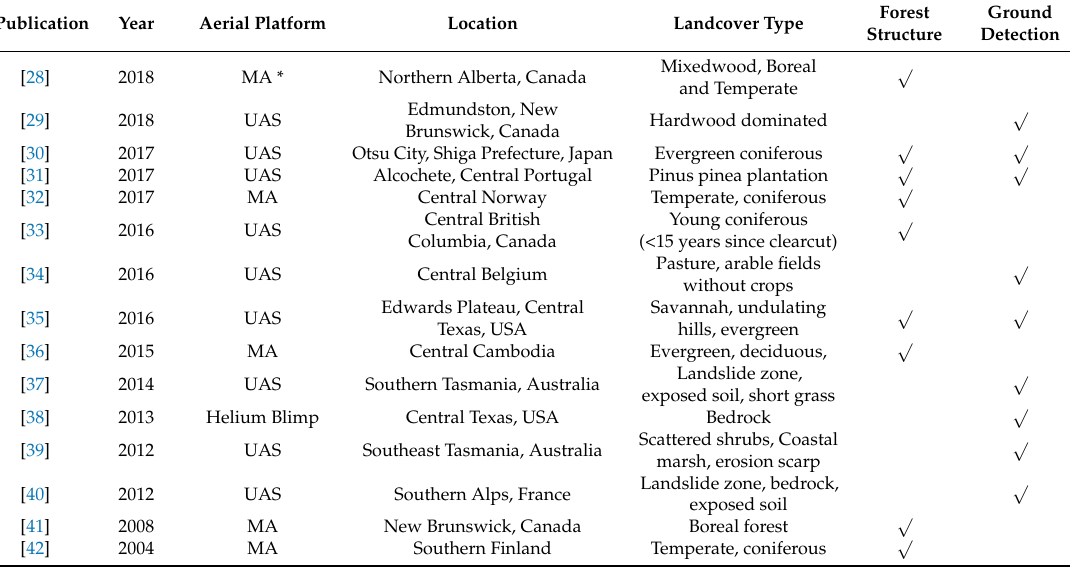
Table 1. Recent studies utilizing digital aerial photogrammetry divided into forest structure and ground